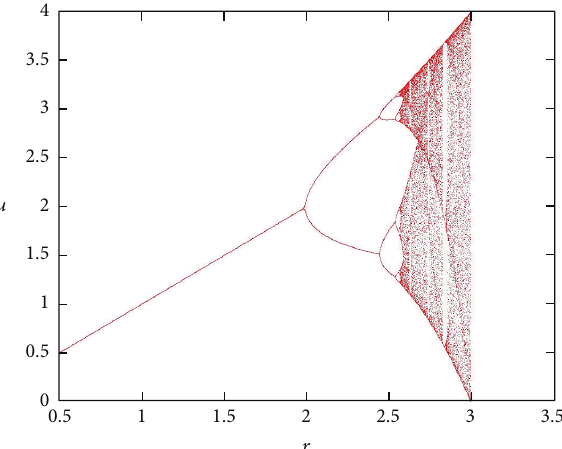
Figure 1: Bifurcation diagram for 𝑟 − 𝑢 𝑡 with 𝑎 = 0.511